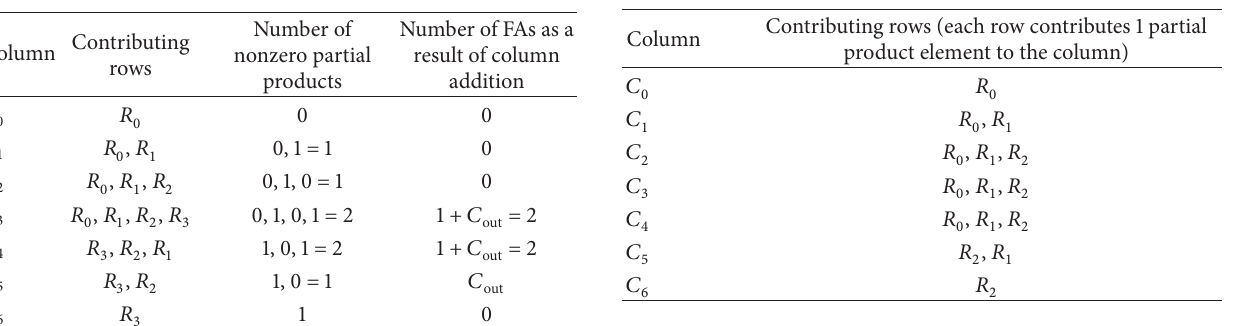
Table 8: Contributing rows for 𝑚 < 𝑛 . Contributing rows (each Column Condition